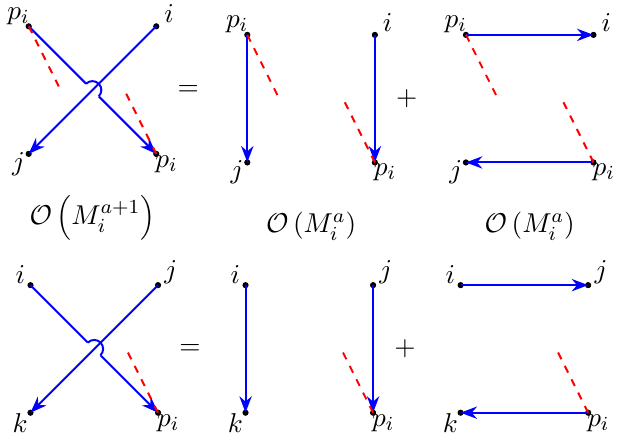
Figure 4 . The notion of mass ordering requires that momentum vertices succeed (or precede) the spin vertex, as dictated by the on-shell conditions p